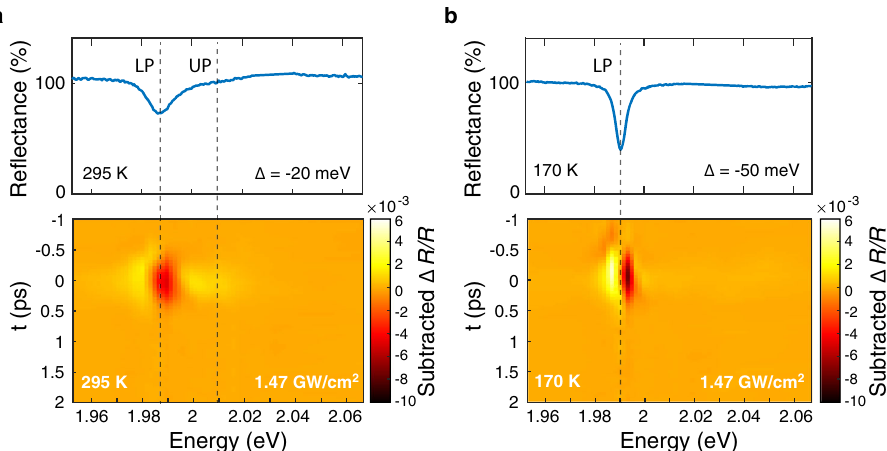
Fig. 4 Valley-selective shift of highly-detuned polaritons. a Re fl ectance spectrum (top) of a photon-like lower polariton at room temperature. The small UP feature is barely discernible near 2.01 eV. Pump-induced shift of the LP dominates the polarization-dependent response of the Δ R / R spectrum (bottom). b Same sample at 170 K, where the exciton is further detuned from the cavity. The LP re fl ectance feature is narrower and deeper due to its more photon-like character and UP is no longer visible. The pump-induced Δ R / R spectrum continues to exhibit strong polarization contrast in this regime, demonstrating how the optical Stark shift of a highly photonic WS 2 polariton still maintains valley selectivity due to its small excitonic